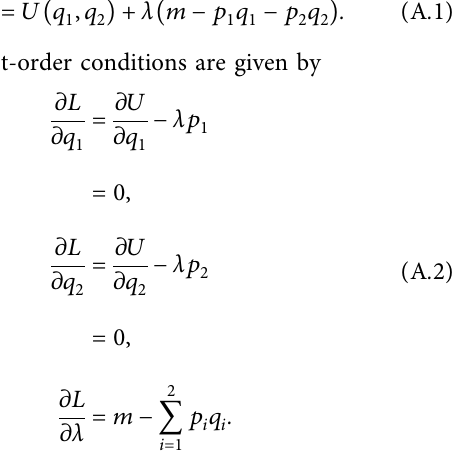
Z i � 1 , 3 i , � 0 . 13 , r � 0 . 15 , 1 2